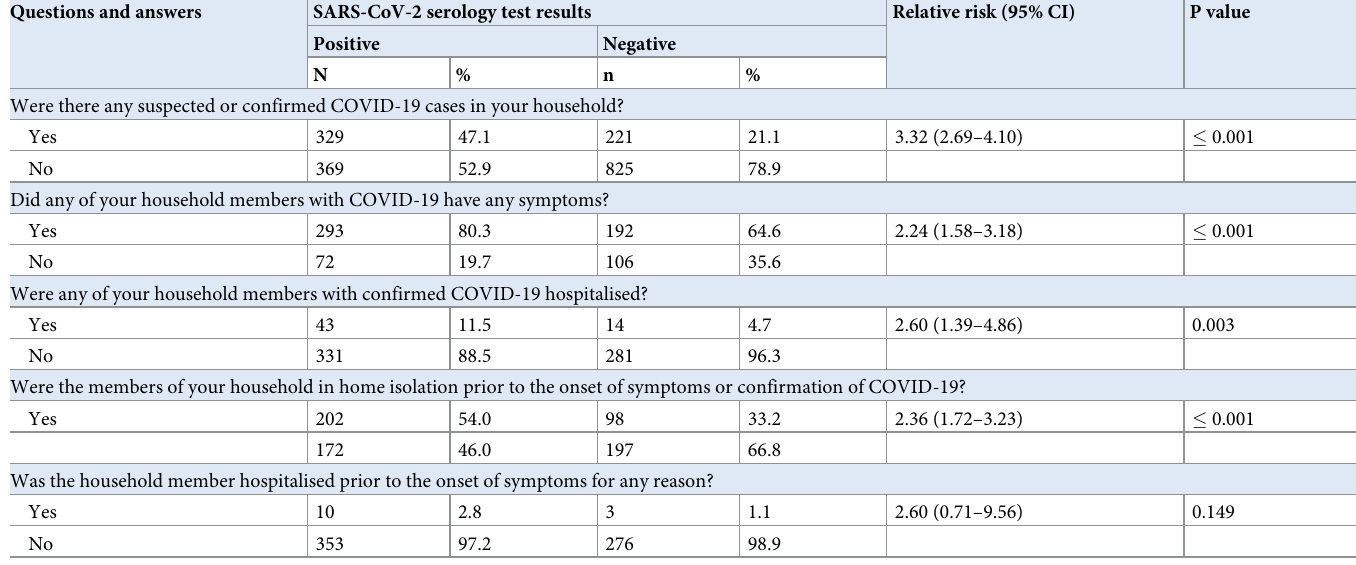
Table 3. COVID 19 symptoms and signs among household members in relation to